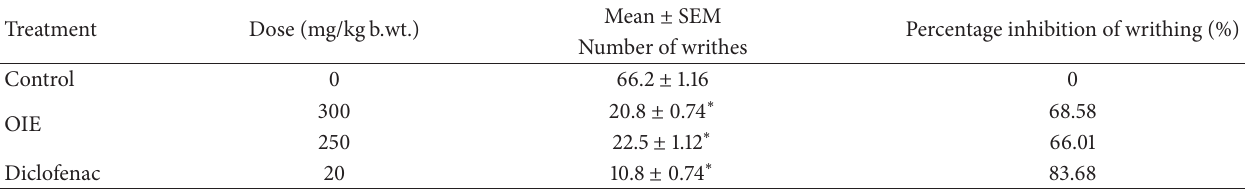
Table 2: Alteration in the analgesic activity by acetic acid induced writhing in mice treated with different doses of Oroxylum indicum . Treatment